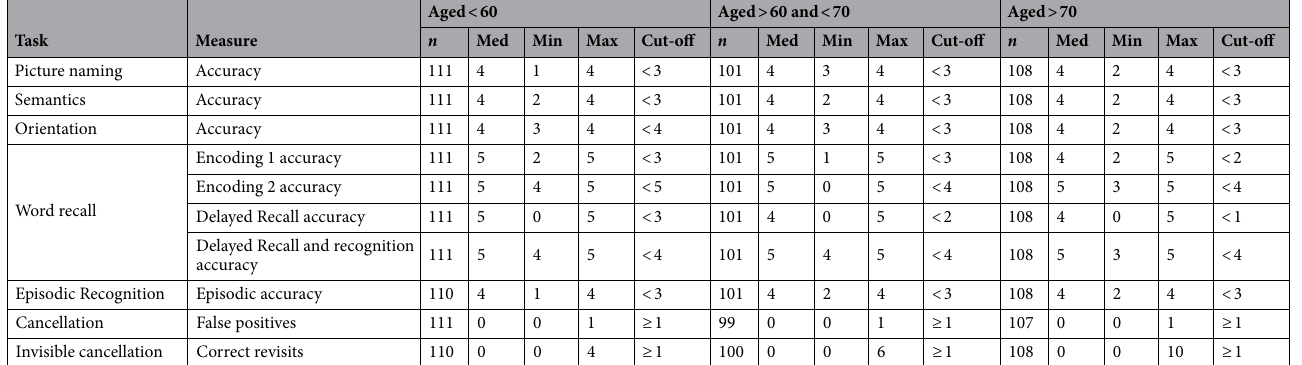
Table 4. Data and cut offs for centile-based impairment per age category (scores lower than 5th centile) for each OCS-Plus subtask. Oxford Cognitive Screen-Plus (OCS-Plus). Cut‑off refers to 5th centile for accuracy data and 95th centile for error data (i.e., false positives and correct revisits). Centiles for false positives and correct revisits were conservatively increased to one as the centile meant that greater than zero errors were considered impaired. Centiles are rounded to nearest whole number.